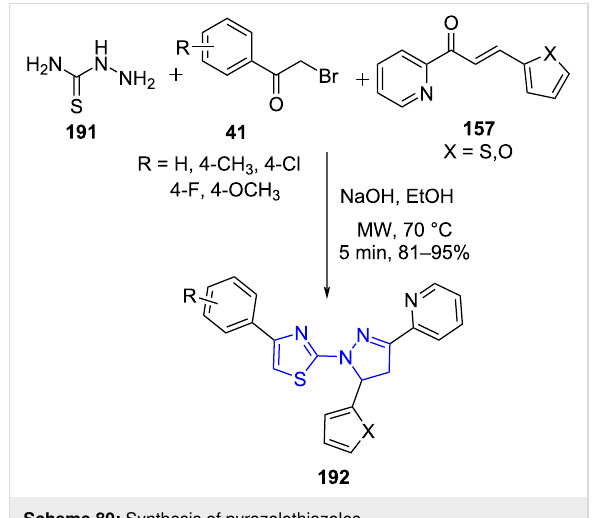
Scheme 80: Synthesis of